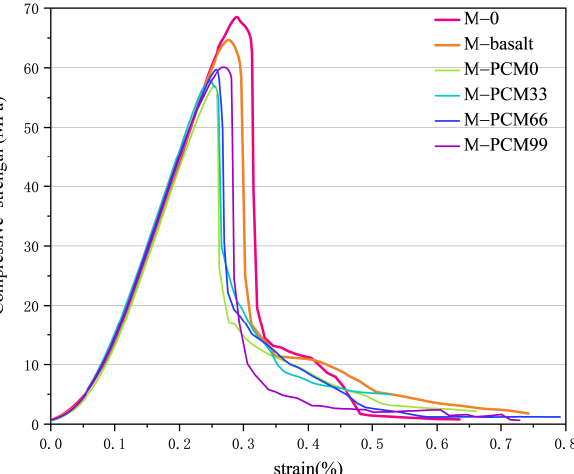
Figure 6. Stress and strain curve of cementitious composite samples under compression for 28 days.